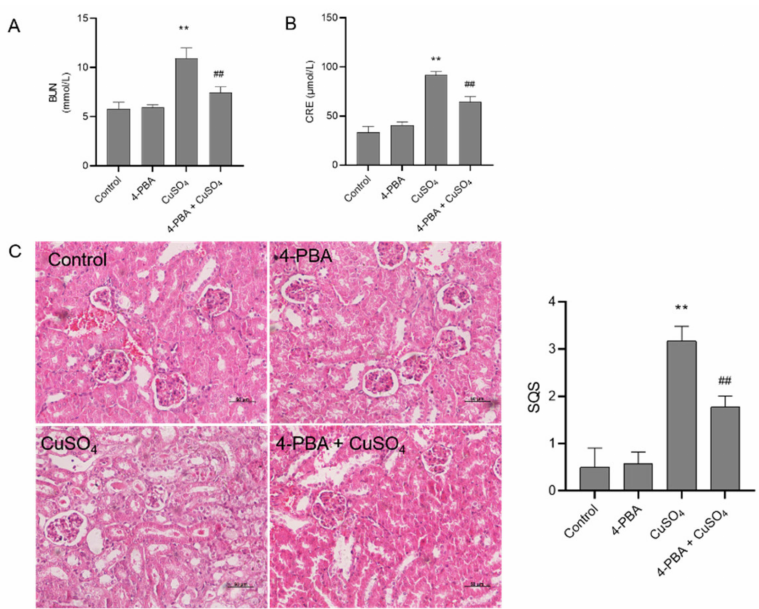
Figure 7. The protective effect of 4-phenylbutyric acid (4-PBA) administration on CuSO 4 exposure-induced nephrotoxicity. ( A , B ) The levels of serum BUN and CRE, respectively. Data are presented as the mean ± SD ( n = 8). ( C ) Representative histopathological changes (left) in kidneys of mice and the semi-quantitative scores (SQSs) (right). SQSs are presented as the mean ± SD ( n = 4). ** p < 0.01, compared to the control group. ## p < 0.01, compared to the CuSO 4 group. Hematoxylin–eosin staining. Bar = 50 µ